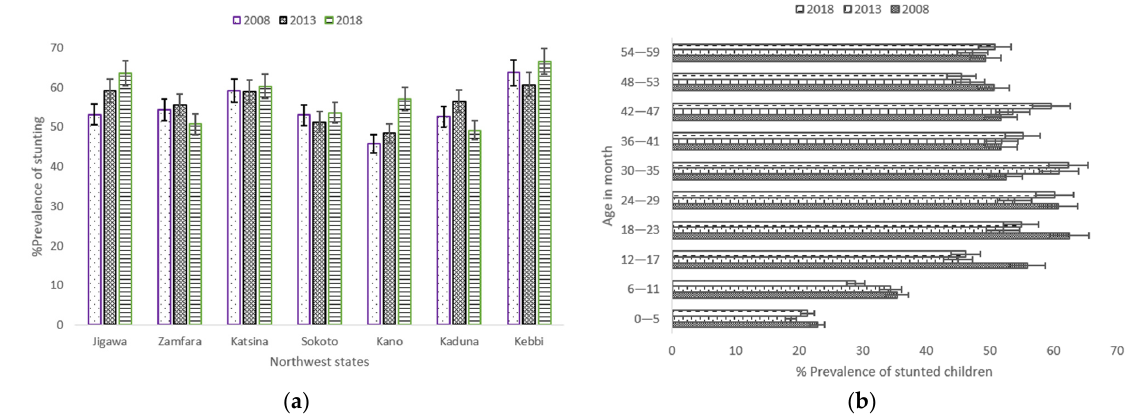
Figure 3. ( a ) Trends in prevalence of stunted children aged 0–59 months, with 95% confidence interval by Northwest states 2008–2018; ( b ) Trends in prevalence of stunted children aged between 0–59 months by child’s age. Notes: If 95% confidence interval (CI) bars do not overlap, it implies that the difference is statistically significant ( p –value < 0.05).